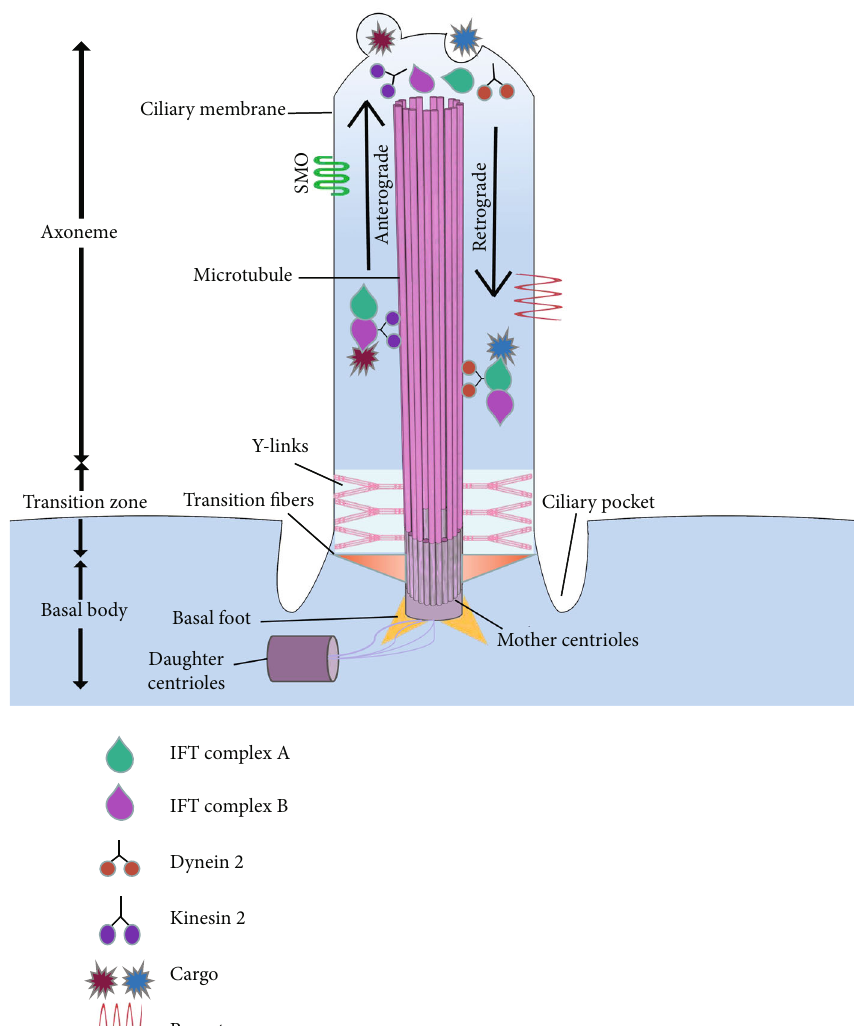
Figure 1: The structure of primary cilium. The cilium structure mostly contains three parts: the basal body, transition zone, and axoneme. The basal body locates at the ciliary bottom, which is associated with other cellular organelles (such as the nucleus and Golgi body). The transition zone is between the basal body and the axoneme, acting as a “ gatekeeper ” ; it controls the entry and exit of various substances and proteins. The axoneme consists of nine pairs of doublet microtubules and covers with a ciliary membrane, which is the main component of primary cilia sensing the extracellular